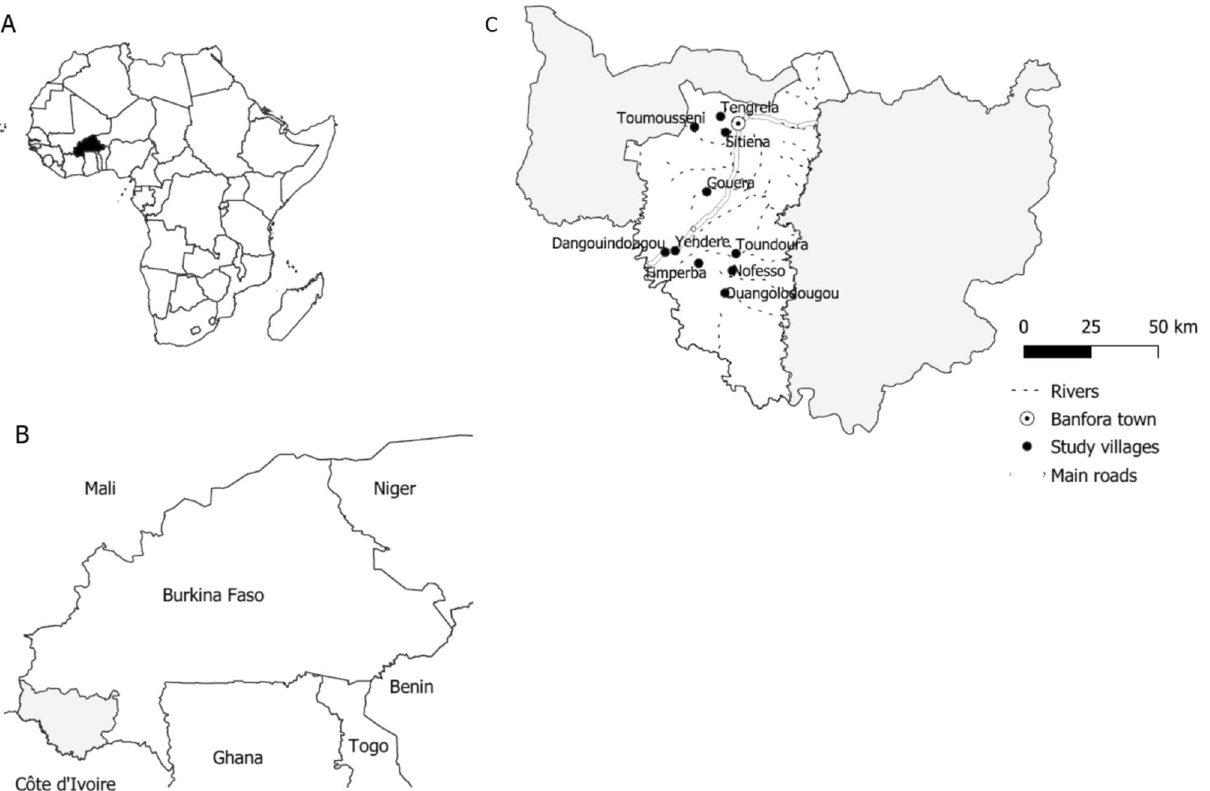
Figure 1. Map of the 10 study villages: ( A ) location of Burkina Faso, ( B ) location of Cascades Region in Burkina Faso and ( C ) location of Banfora Health District and study villages in Cascades Region. The map was generated using QGIS 3.16 19 . Background layers were downloaded for OpenStreetMap 20 , villages were digitised by the authors using GPS coordinates collected in the field using a GARMIN eTREX 10